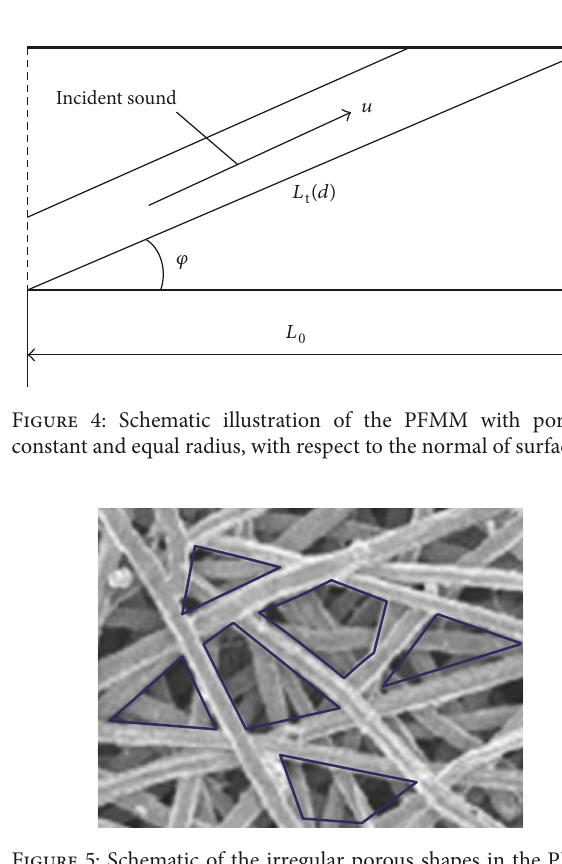
Figure 5: Schematic of the irregular porous shapes in the PFMM